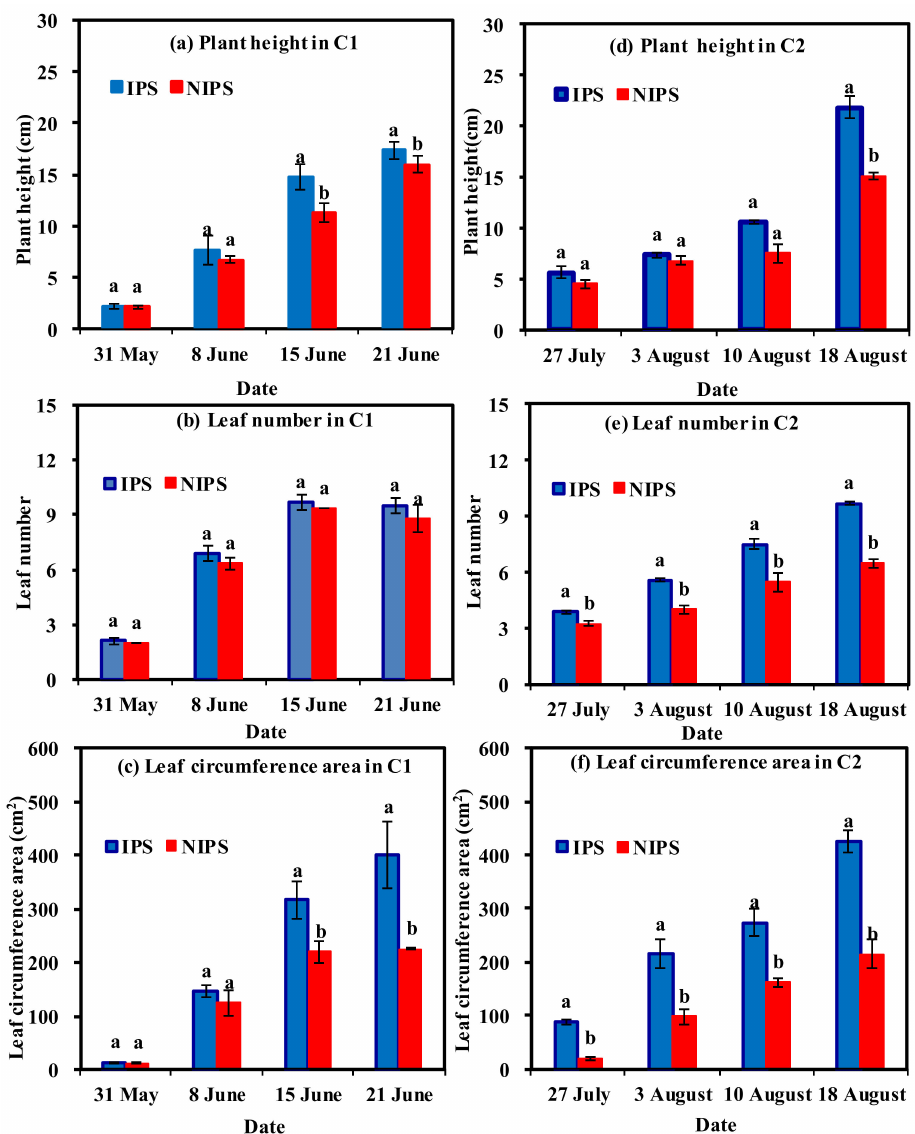
Figure 9. The variation of ( a , d ) the plant height, ( b , e ) leaf number, and ( c , f ) leaf circumference area during C1 and C2. The vertical bar represents one standard deviation. Different letters above bars indicate significant differences among treatments at the level of